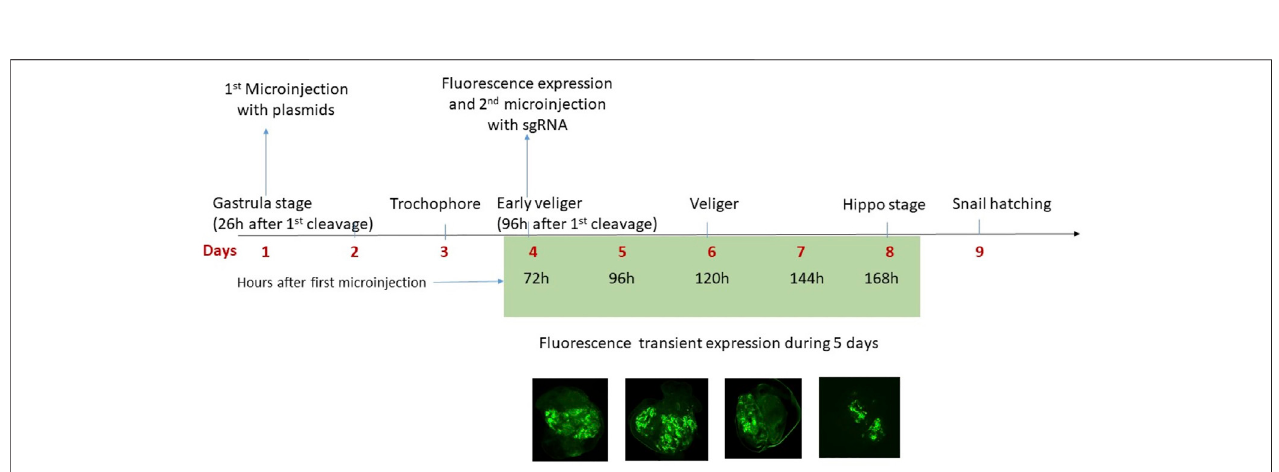
FIGURE5 | The microinjection was done at thegastrula stage, 26 h after the fi rst cleavage of the zygote. In total, 72 h after the fi rst microinjection the plasmids are expressed in the embryo of B. glabrata and in the fl uorescent positive embryos a second microinjection with the sgRNA was done. The fl uorescence of the reporter genes (GFP and BFP) was observed for 5 days (from Day 4 to Day 8) and then is no longer visible, therefore the expression of reporter genes carried by plasmids is transient. At Day 9, the snails hatch.